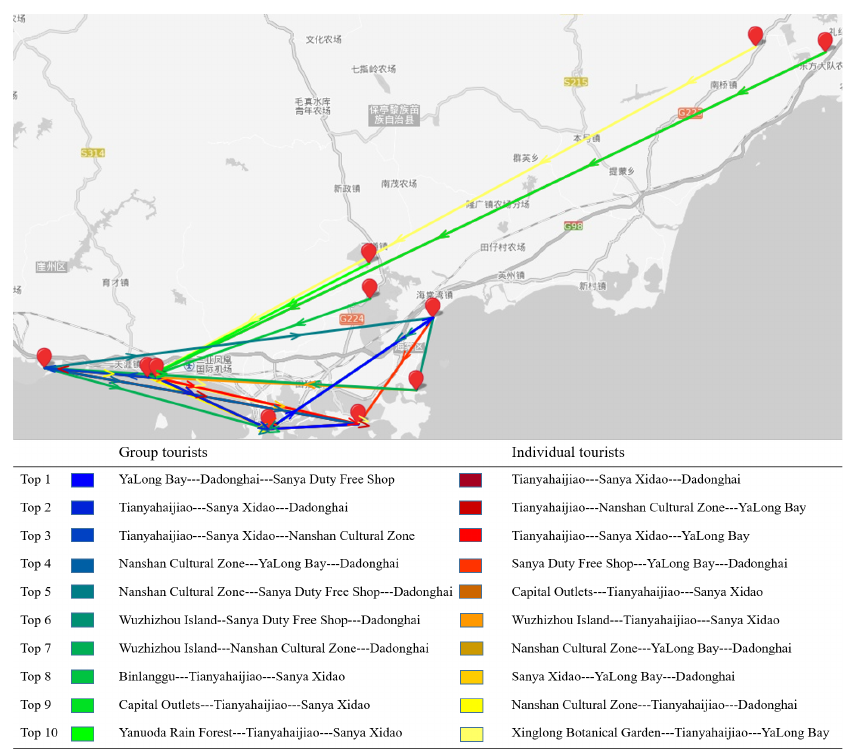
Figure 11. Top 10 popular routes with three scenic